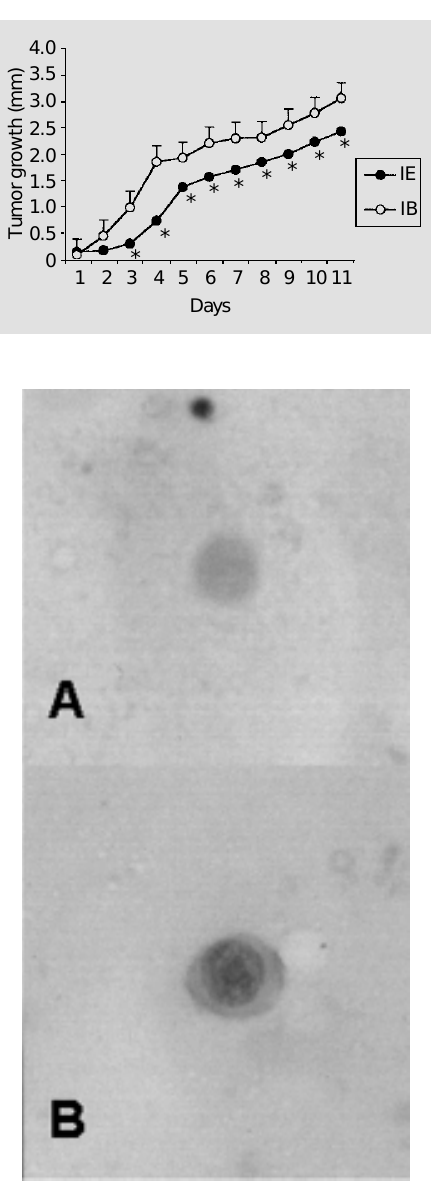
Figure 1 - Inhibition of tumor size by preincubation of Ehrlich cells with an extract of submandibu- lar gland cells (SGE; IE group) or PBS (IB group). The experiment is described in the legend to Table 1. Data are reported as means ± SD tumor size.